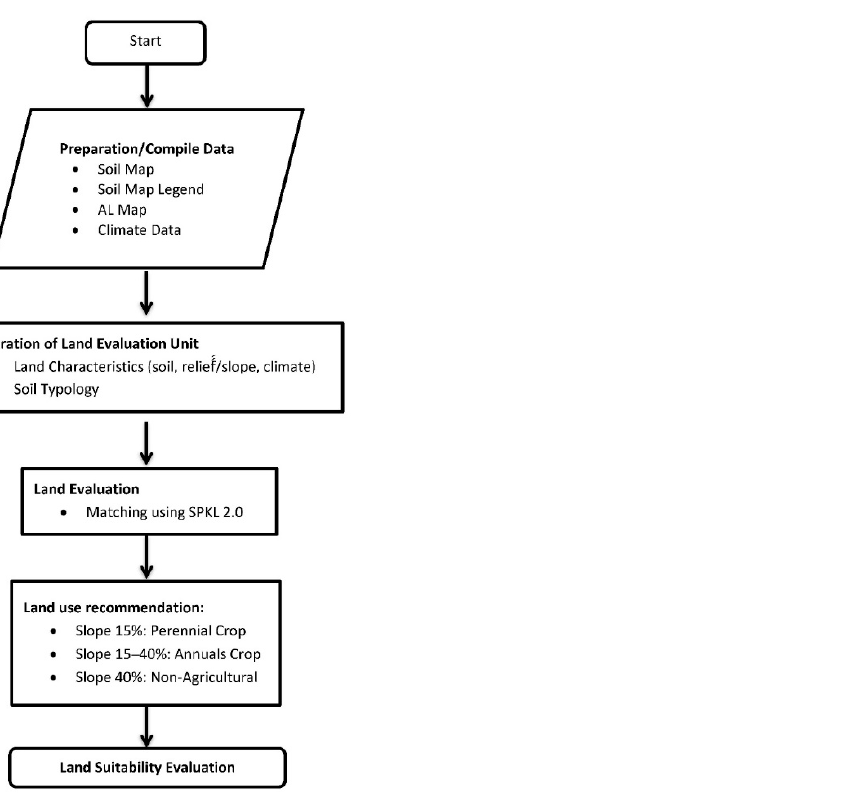
Figure 3. The procedure to generate land suitability maps for the agricultural development in AL.